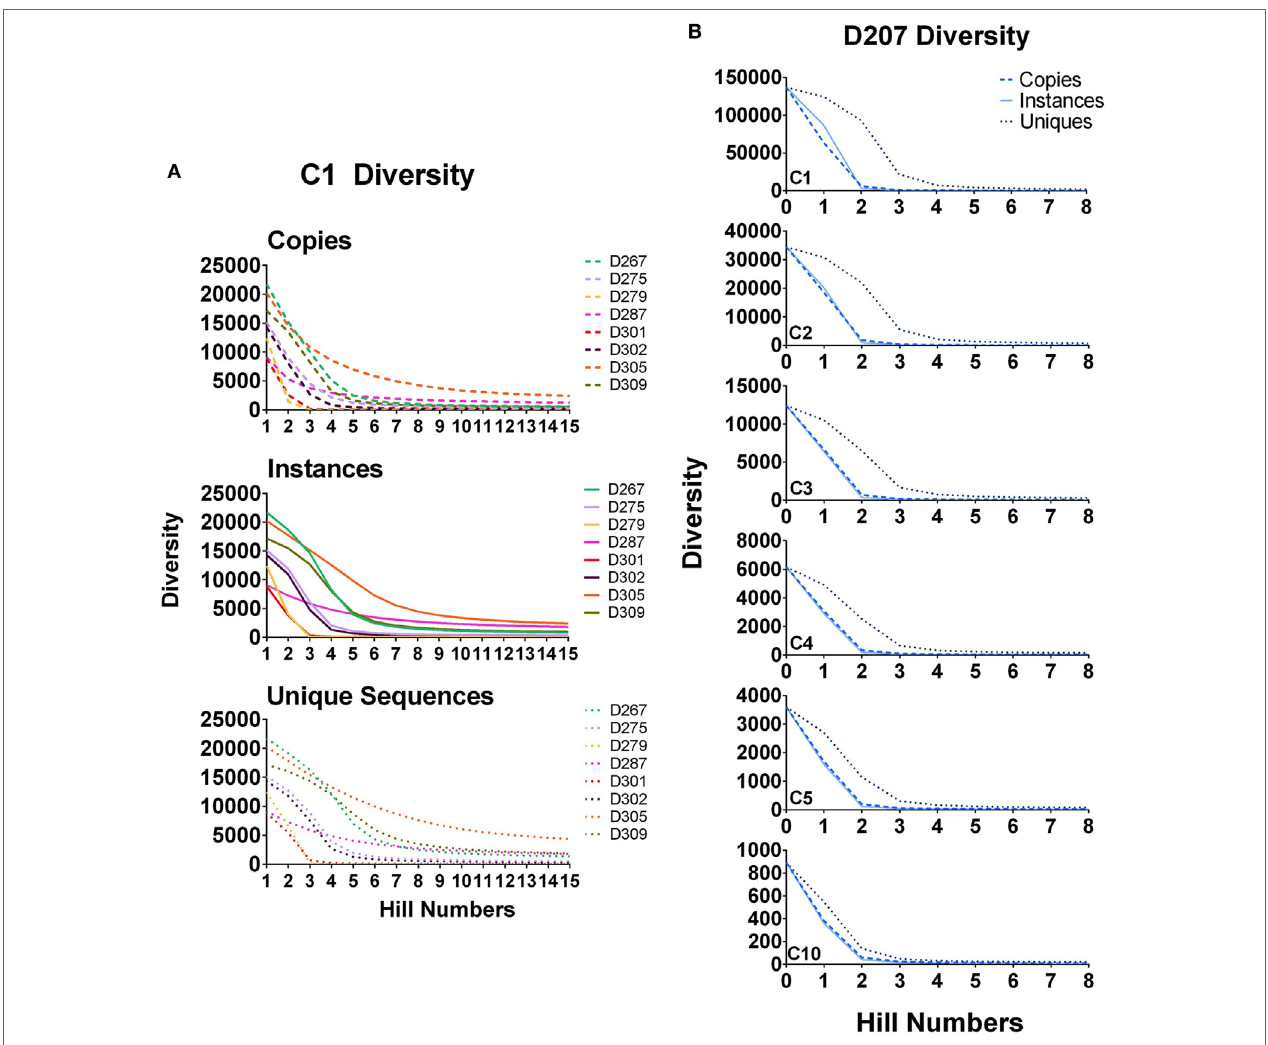
FIgUrE 6 | Diversity at different orders. (A) Diversity of C1 clones (all clones) calculated for all donors at survey level by instances, copies, and unique sequences; (B) Diversity of C1, C2, C3, C4, and C5 clones in D207. True diversity is calculated using copies, instances, and unique sequences (see text). Calculations are performed at different orders (Hill numbers). Higher orders give more weight to larger